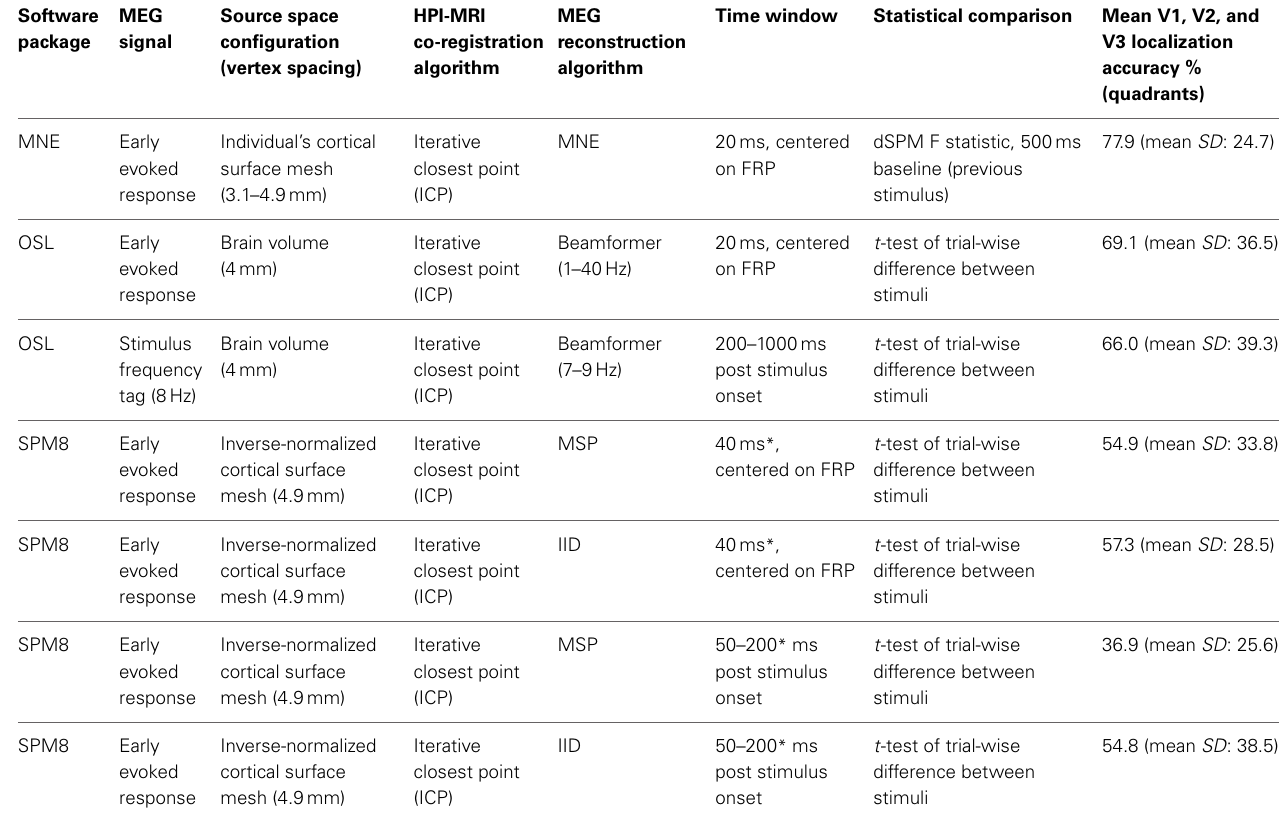
Table 1 | Source reconstruction method details for all localization accuracy